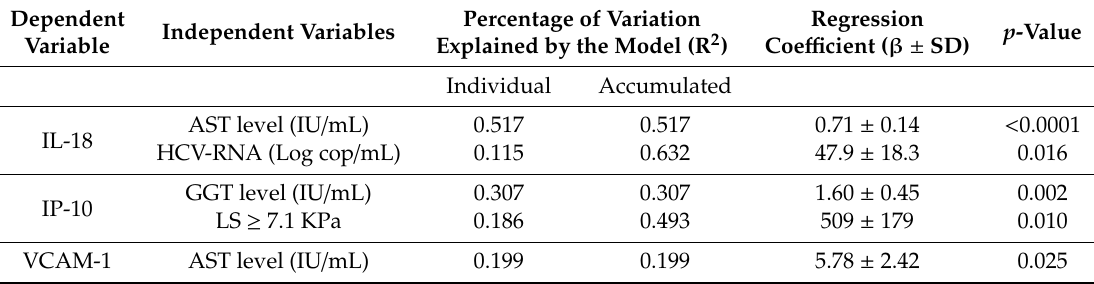
Table 2. Linear regression models showing the variables significantly and independently associated with the baseline level of IL-18, IP-10 and